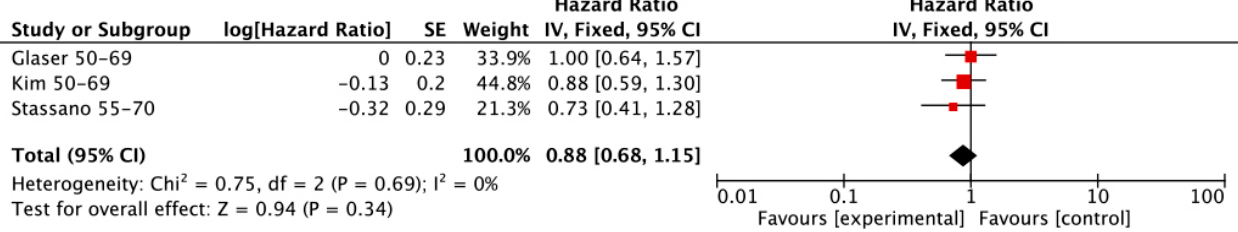
Figure 4. Meta ‐ analysis for freedom from cardiac death: bioprosthetic vs. mechanical.